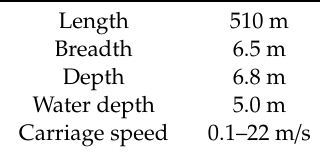
Table 2. Principle dimensions and parameters of the towing tank.